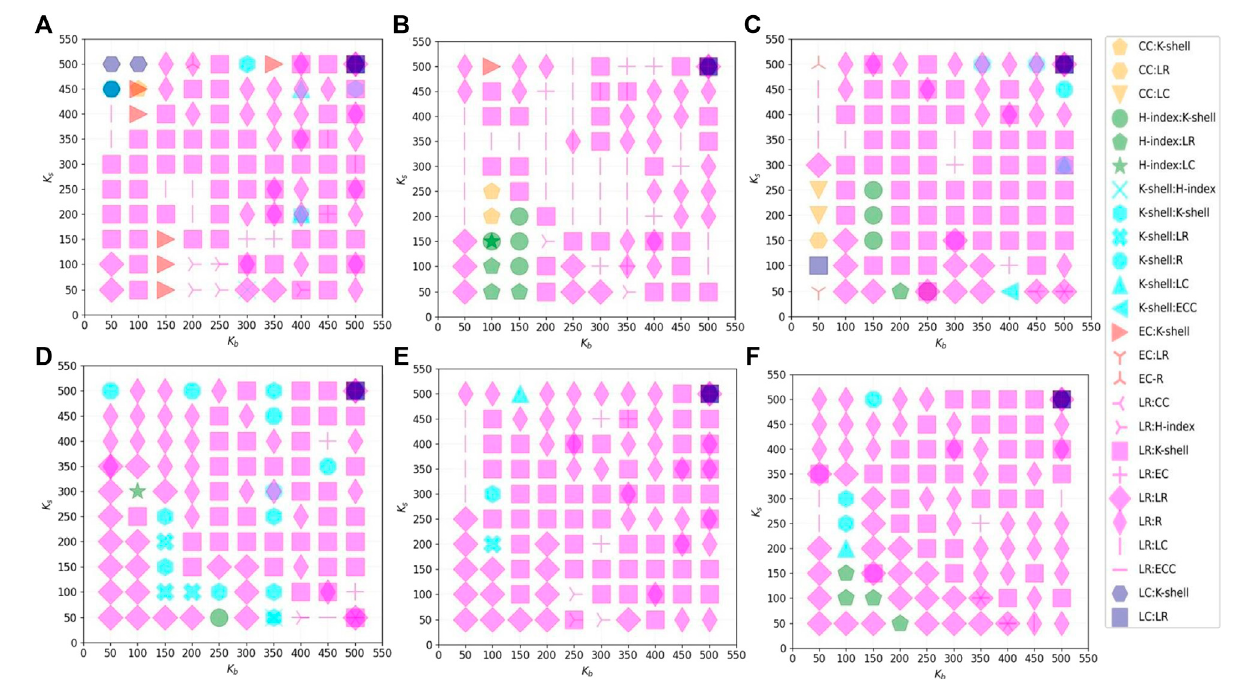
FIGURE 3 | The adversarial strategy pair at dynamic equilibrium obtained by backward induction solving. Where the horizontal axis denotes the number of seed nodes K b fortheblockerandtheverticalaxisdenotesthenumber ofseednode K s forthespreader.Eachsubplotshowstheexperimental resultsonthesamescale-free network. (A) Power exponent γ = 2.0; (B) power exponent γ = 2.1; (C) power exponent γ = 2.2; (D) power exponent γ = 2.3; (E) power exponent γ = 2.4; (F) power exponent γ = 2.5.